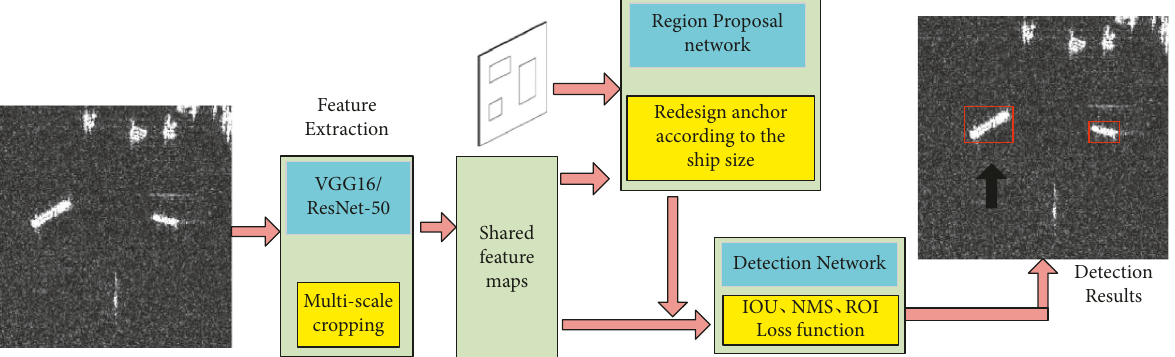
Figure 9: Ship detection network